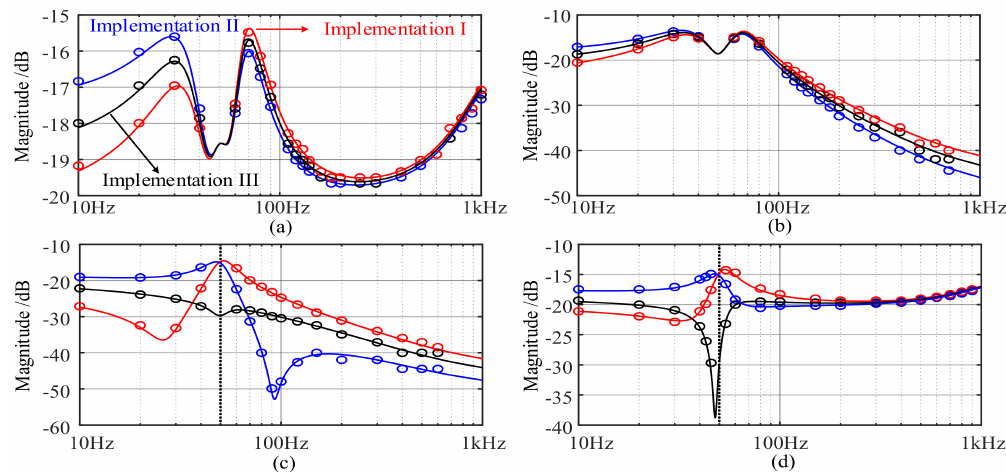
Figure 6. Magnitude responses of admittances of the converter synchronized by a SRF-PLL: ( a ) Y pp ( s + j ω 1 ); ( b ) Y pn ( s + j ω 1 ); ( c ) Y np ( s − j ω 1 ); ( d ) Y nn ( s − j ω 1 ). Red line: Implementation I; Green line: implementation II; Black line: implementation III is applied. Circles: numerical simulation results.